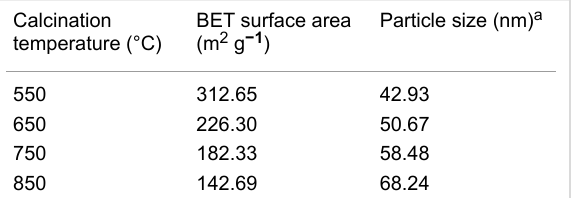
Table 1: Effect of calcination temperature on BET surface area and particle size of MoO 2 .